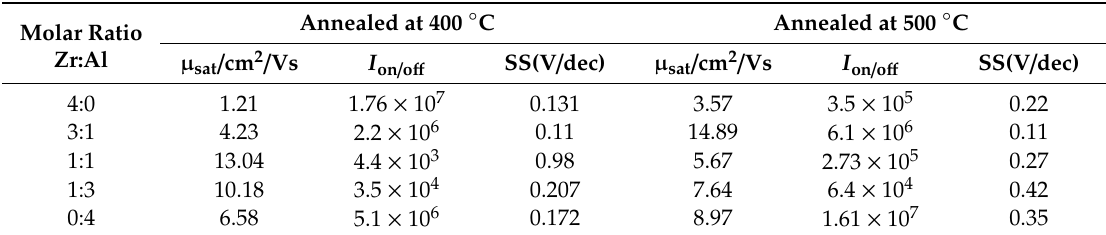
Figure 10. ( a ) Output curves of IGZO / ZAO (Zr:Al = 3:1) TFT at 400 ◦ C; ( b ) transfer curves of IGZO / ZAO (Zr:Al = 3:1) TFT at 400 ◦ C; ( c ) output curves of IGZO / ZAO (Zr:Al = 3:1) TFT at 500 ◦ C; and ( d ) transfer curves of IGZO / ZAO (Zr:Al = 3:1) TFT at 500 ◦ C. Table 5. Electric characteristics of the devices.